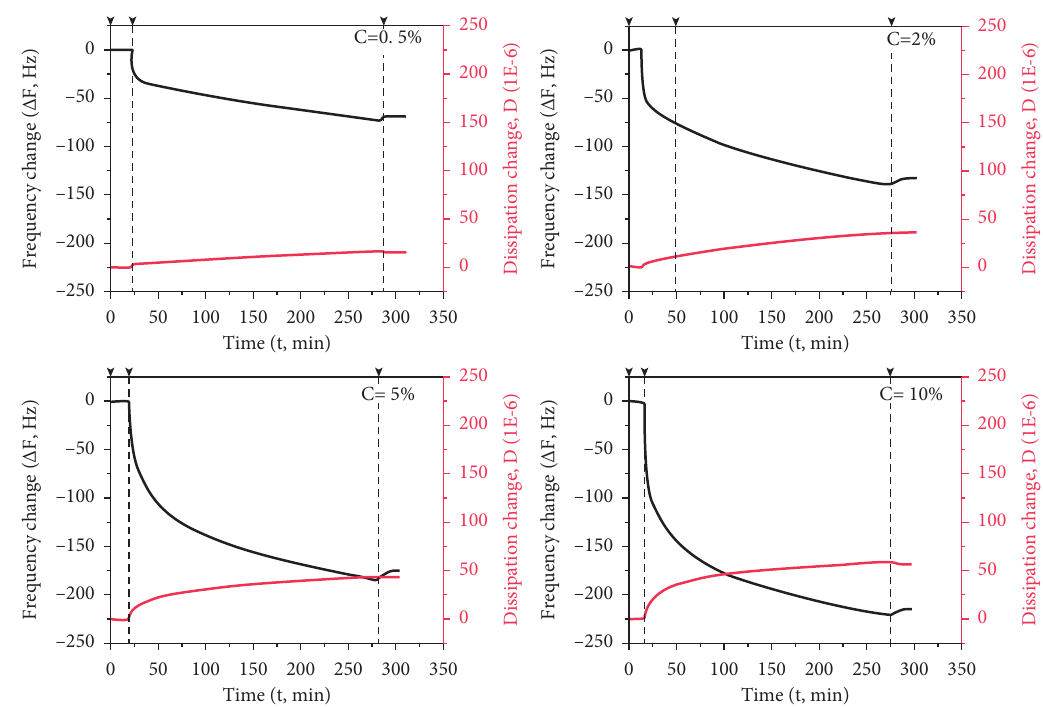
Figure 6: QCM-D results of different concentrations of PD-7.